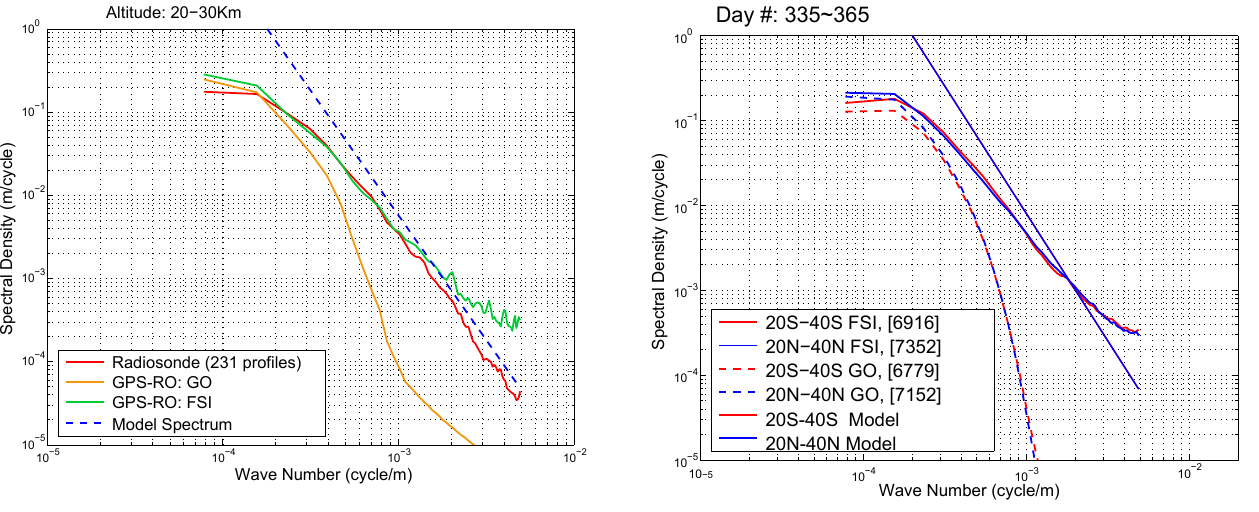
Fig. 6. Vertical wave number spectra from the COSMIC data in De- cember 2006 at 20 ◦ –40 ◦ S (red lines) and 20 ◦ –40 ◦ N (blue lines). Solid and dashed lines correspond to the FSI and GO methods, re- spectively. The number of GPS RO profiles used to calculate the mean spectra is shown in parentheses. The straight line indicates the model spectrum with N 2 = 5 . 57 × 10 − 4 (rad 2 s − 2 )